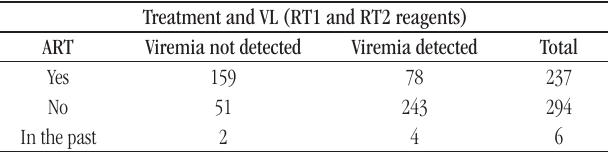
taBLE 2 − Relationship between ART use and viral RNA detection rate Treatment and VL (RT1 and RT2 reagents)